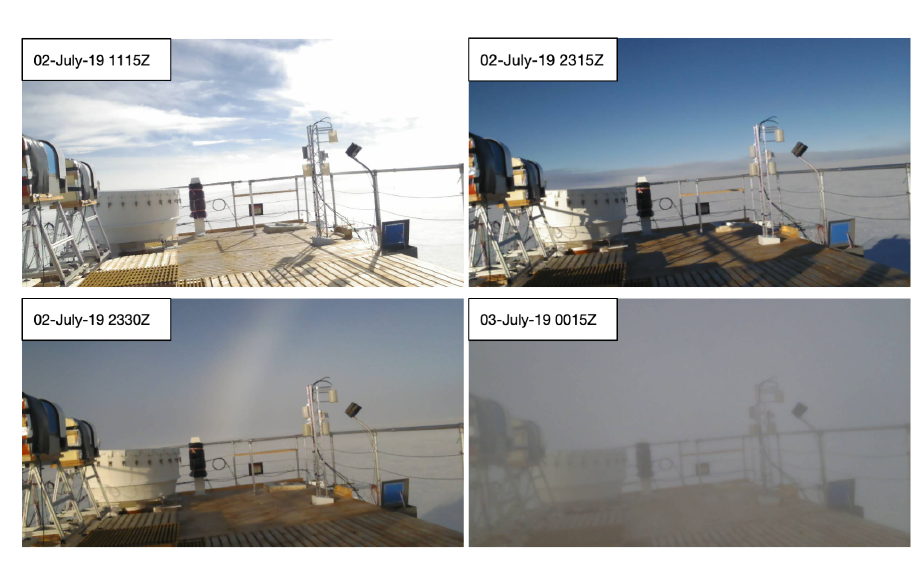
Figure 12. Photographs from a webcam oriented towards the eastern horizon on 2 and 3 July 2019. The aerosol inlet is visibly mounted on the mast in the SE